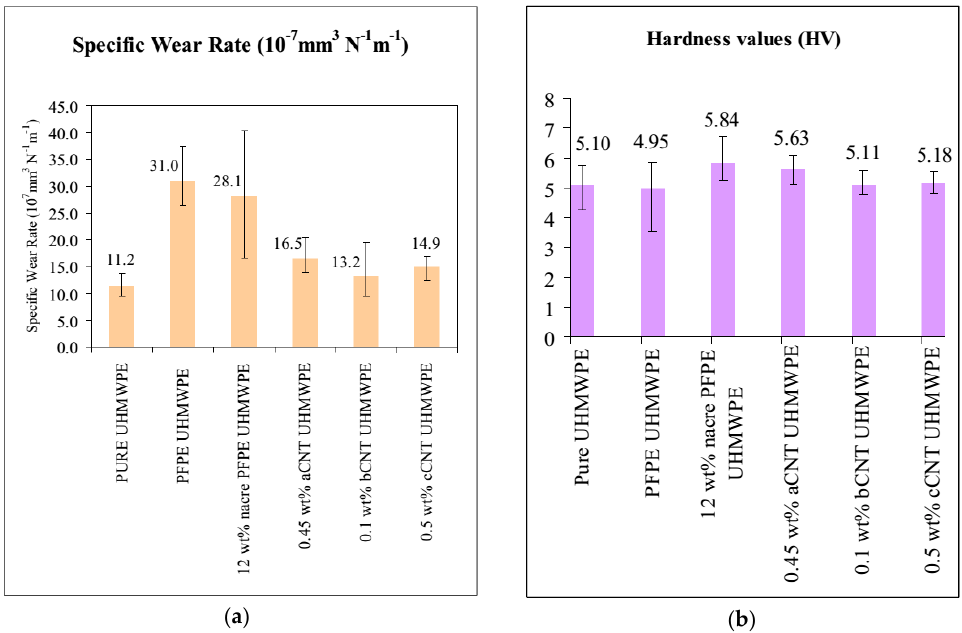
Figure 7. ( a ) Wear rate for different UHMWPE composites ( b ) The Vickers hardness values for different UHMWPE composites. Reprinted with permission from [126].